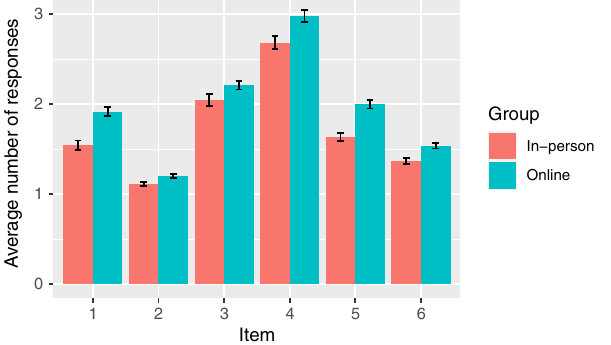
FIG. 2. Average number of answer choices selected by In- stitution 1 students for the six MCMR PIQL items. Items 1, 2, 5, and 6 have one correct answer choice; item 3 has three correct answer choices, and item 4 has two.